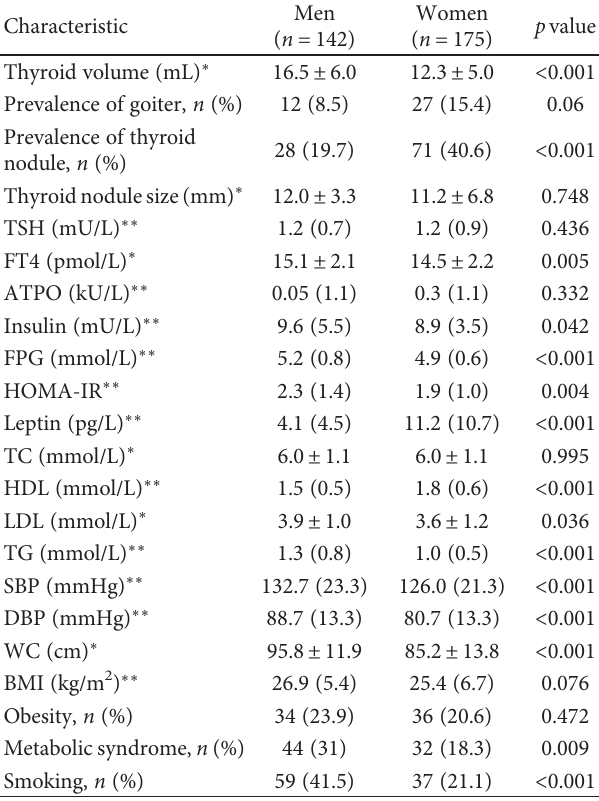
Table 1: Characteristics of the study